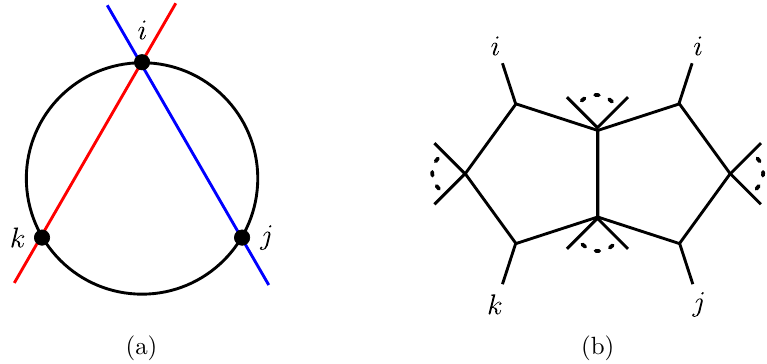
Figure 3. (a) A maximum codimension boundary of the two-loop MHV amplituhedron. (b) The corresponding Landau diagram (which, it should be noted, does not have the form of a standard Feynman integral) depicting the nine cut conditions (3.7){(3.9) that are satis(cid:12)ed on this boundary. Other relaxations either give no constraint on kinematics, or the same as eq. (3.5) with i ! i +1 and/or j ! j